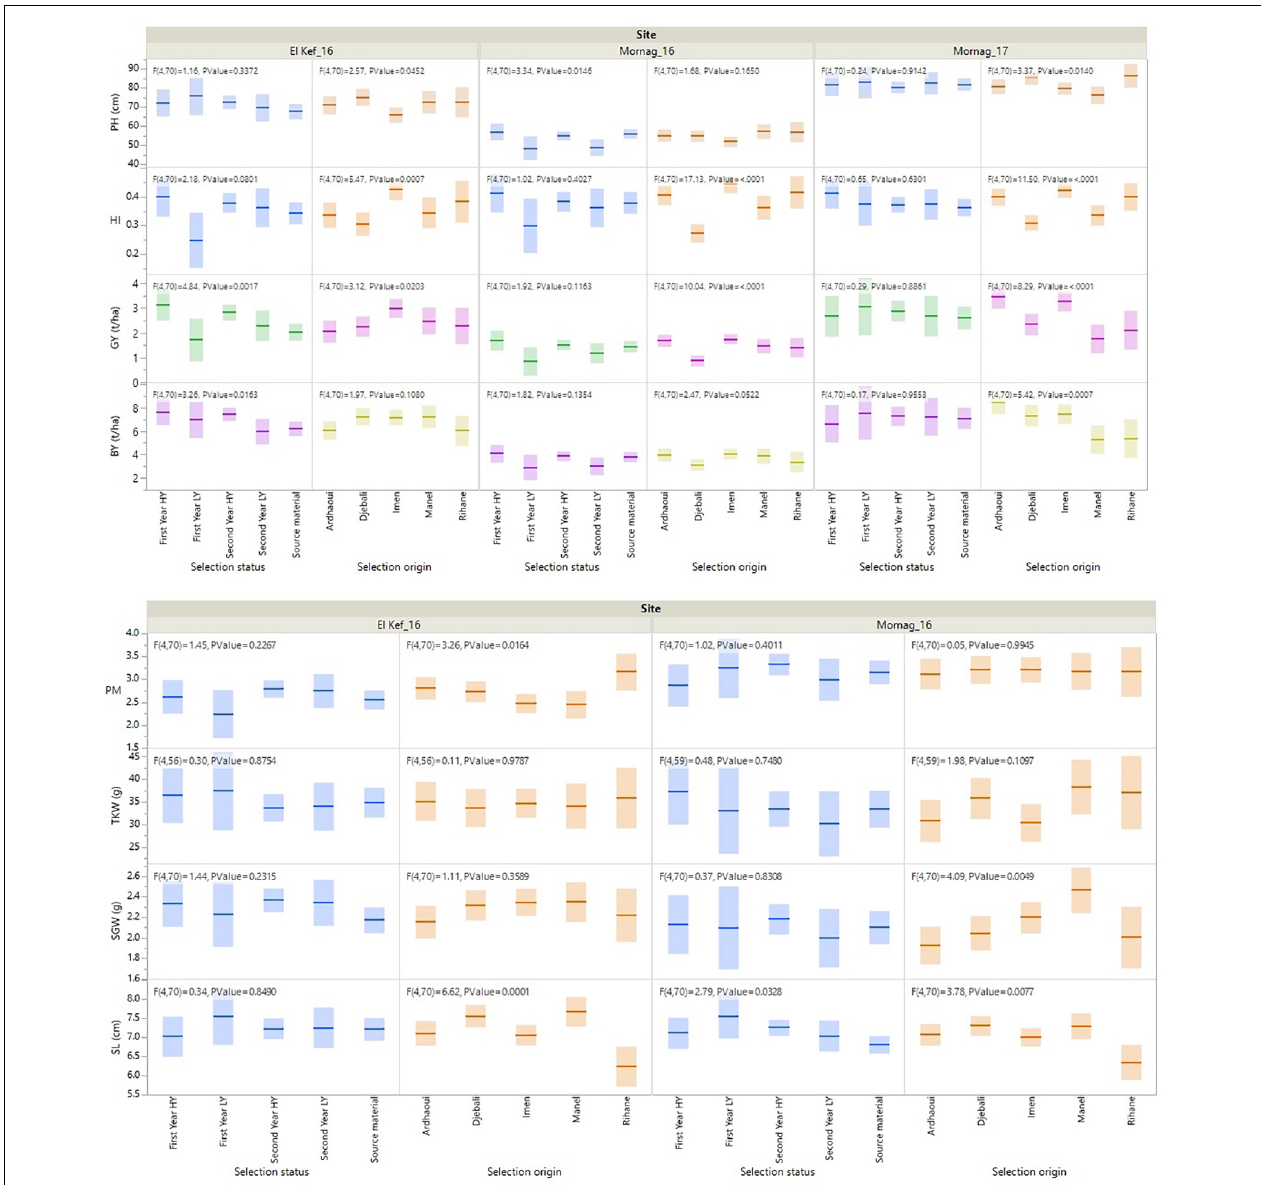
FIGURE 1 | Fit of means for the agronomic traits of barley lines selected under ultra-low density when evaluated under dense stand trials in distinct environments in